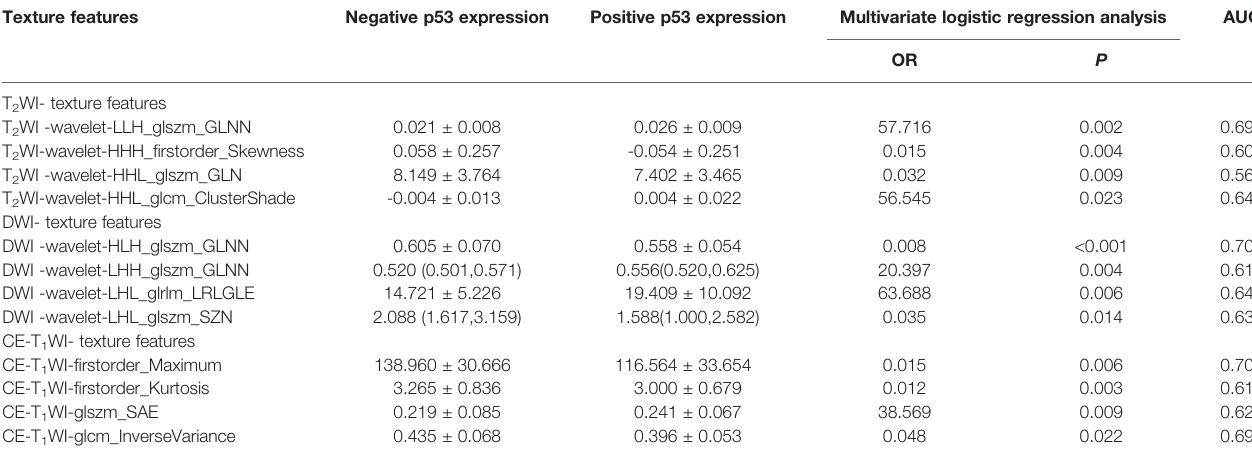
TABLE 4 | Statistical results of texture features of p53 negative and positive expression groups in EC. Texture features